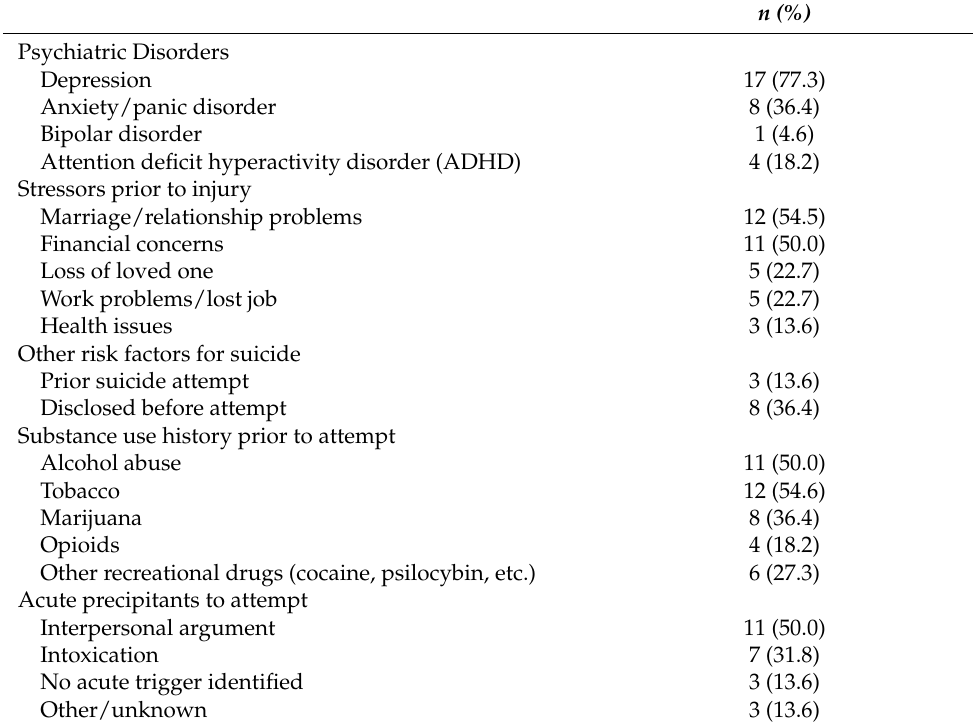
Table 3. Psychiatric and substance use histories of patient cohort (N = 22).